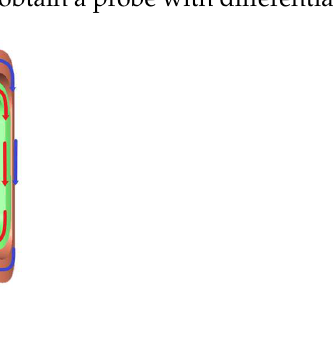
Figure 19. Concept probe with the best performance simulated. ( a ) Top view of the probe with the Figure 18. Example of a numerical simulation performed to compare the performance of the five excitation coil represented in red and the sensing coils in green; ( b ) Probe modeled in Ansys ECT probe concepts. The evaluation of the excitation strength and distribution were the target of Electronics used for the simulations. this specific simulation.